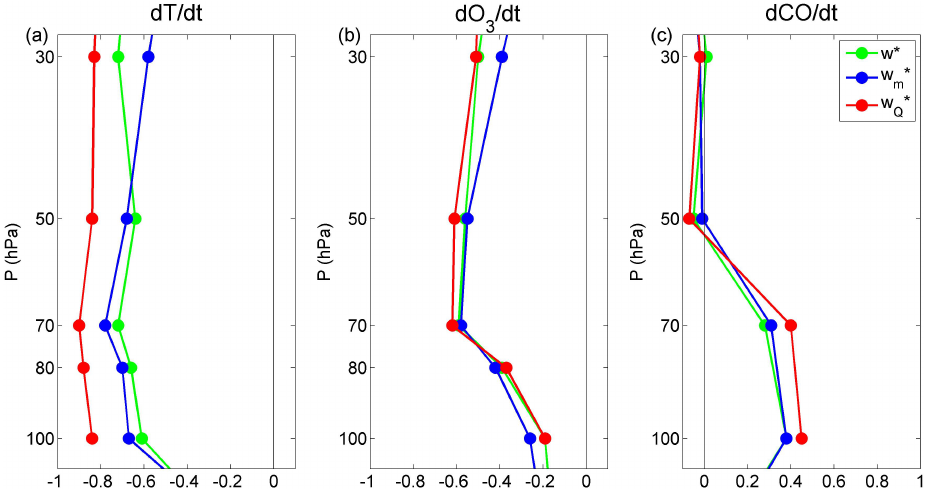
Fig. 10. Linear correlations as a function of pressure between the upwelling estimates and temperature (a) , ozone (b) and CO (c) tendencies. Results are shown for the three estimates ( w ∗ in green, w ∗ m in blue and w ∗ in red). The correlations are calculated between the sub-seasonal Q time series (6 days < periods < 1yr) as shown in Fig. 10 but for the 6-yr long (2005–2010) time series. The 99% significance level is α ∼ 0.12.